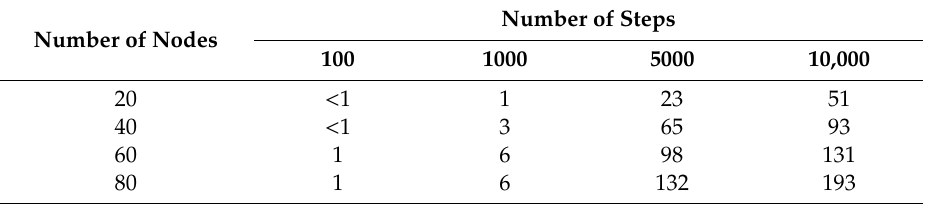
Table 1. The real computation time [s] for a given number of nodes and simulation steps.